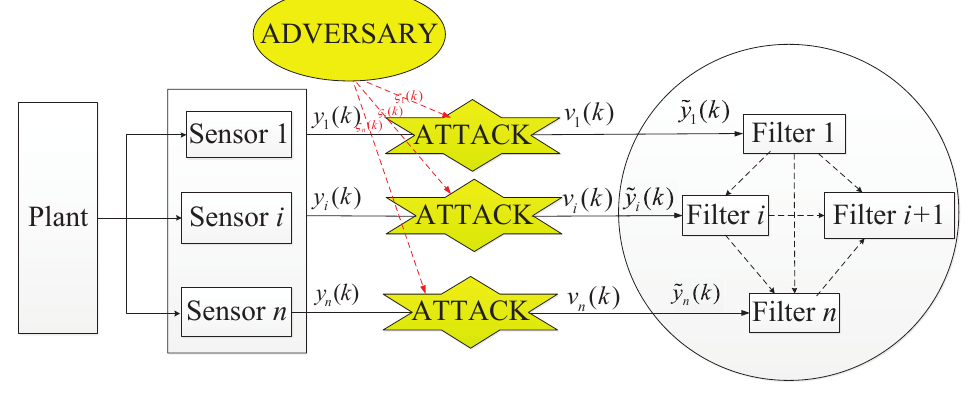
Figure 1. Distributed filtering network with deception